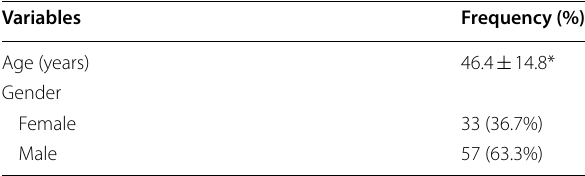
Table 1 Socio‑demographic data among 90